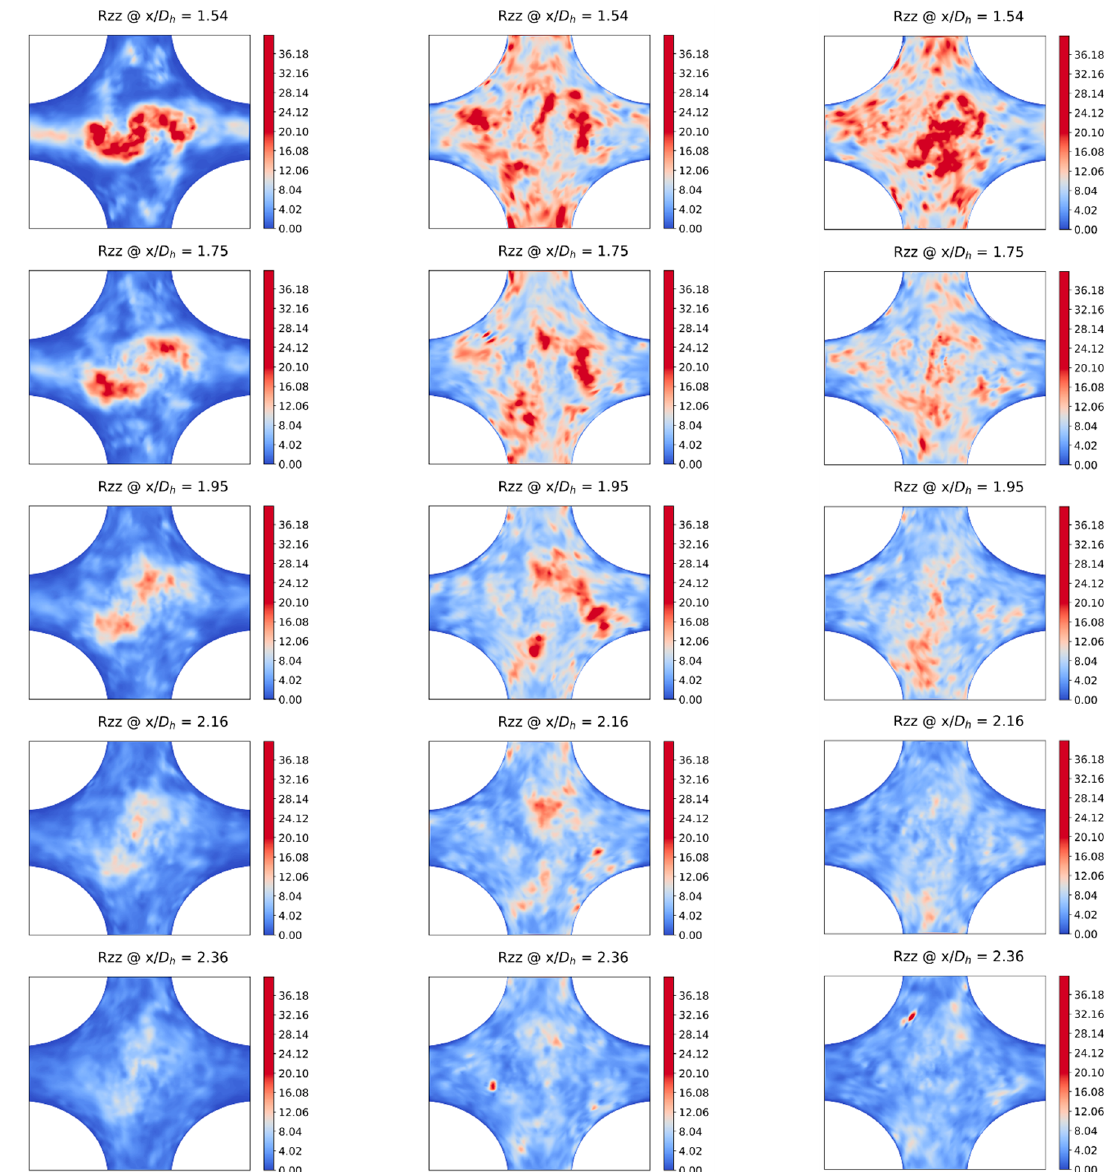
Figure 14. Axial evolution of downstream normalized lateral ( 𝒛 ) component of Reynolds stress for the single-phase ( left ), We40 ( middle ) and We80 ( right ) cases.